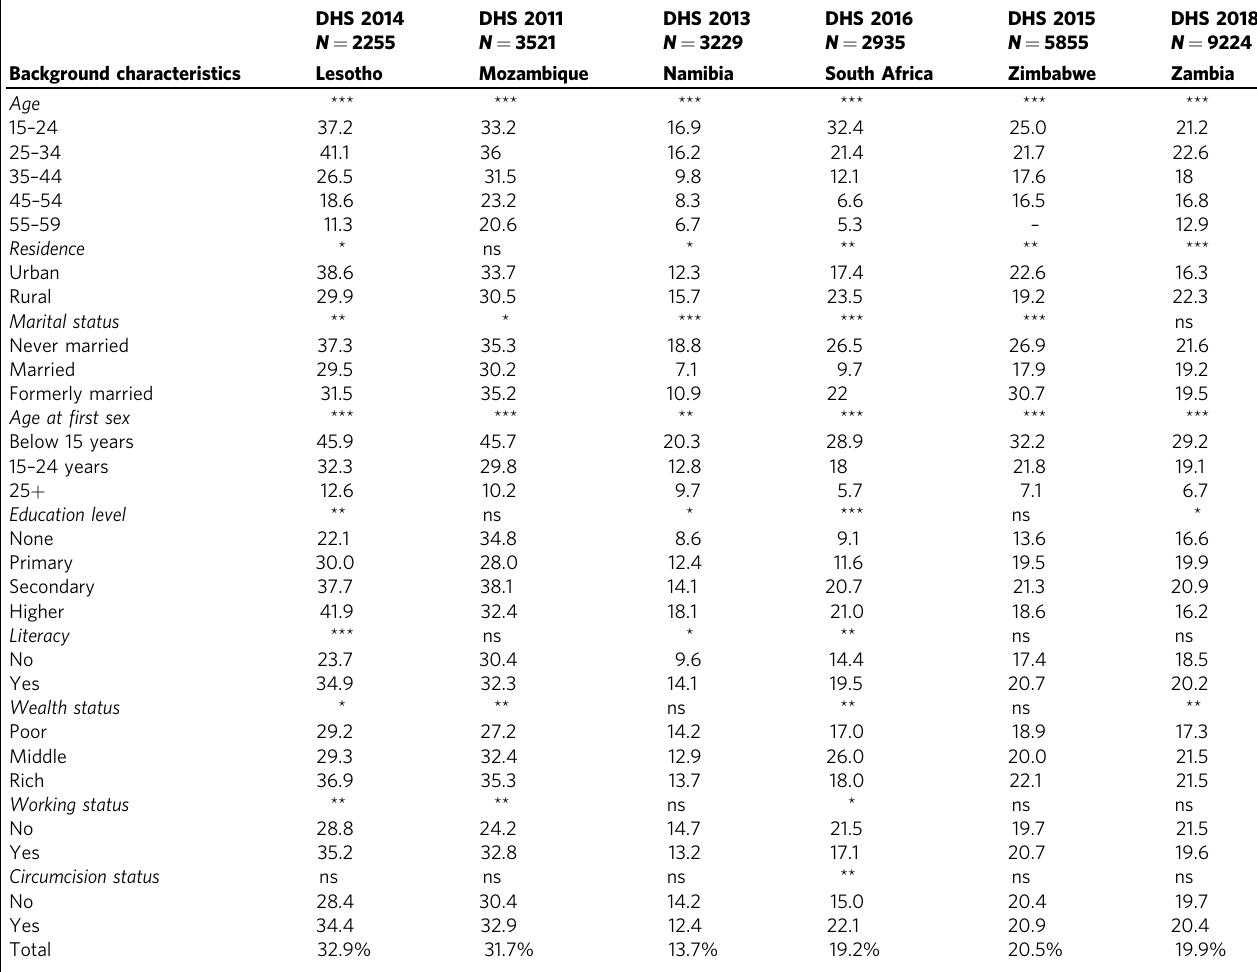
Table 2 Percentage distribution of men with multiple sexual partnerships by background characteristics, Southern